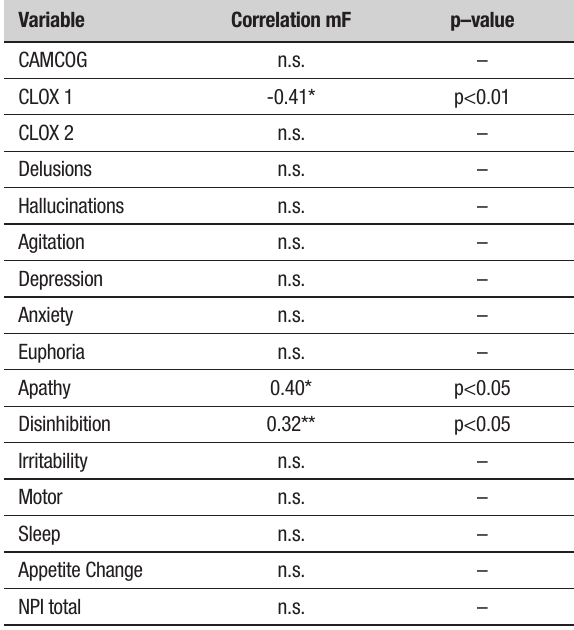
Table 4. Correlations between mF and behavioral and cognitive variables, after controlling for degree of hippocampal